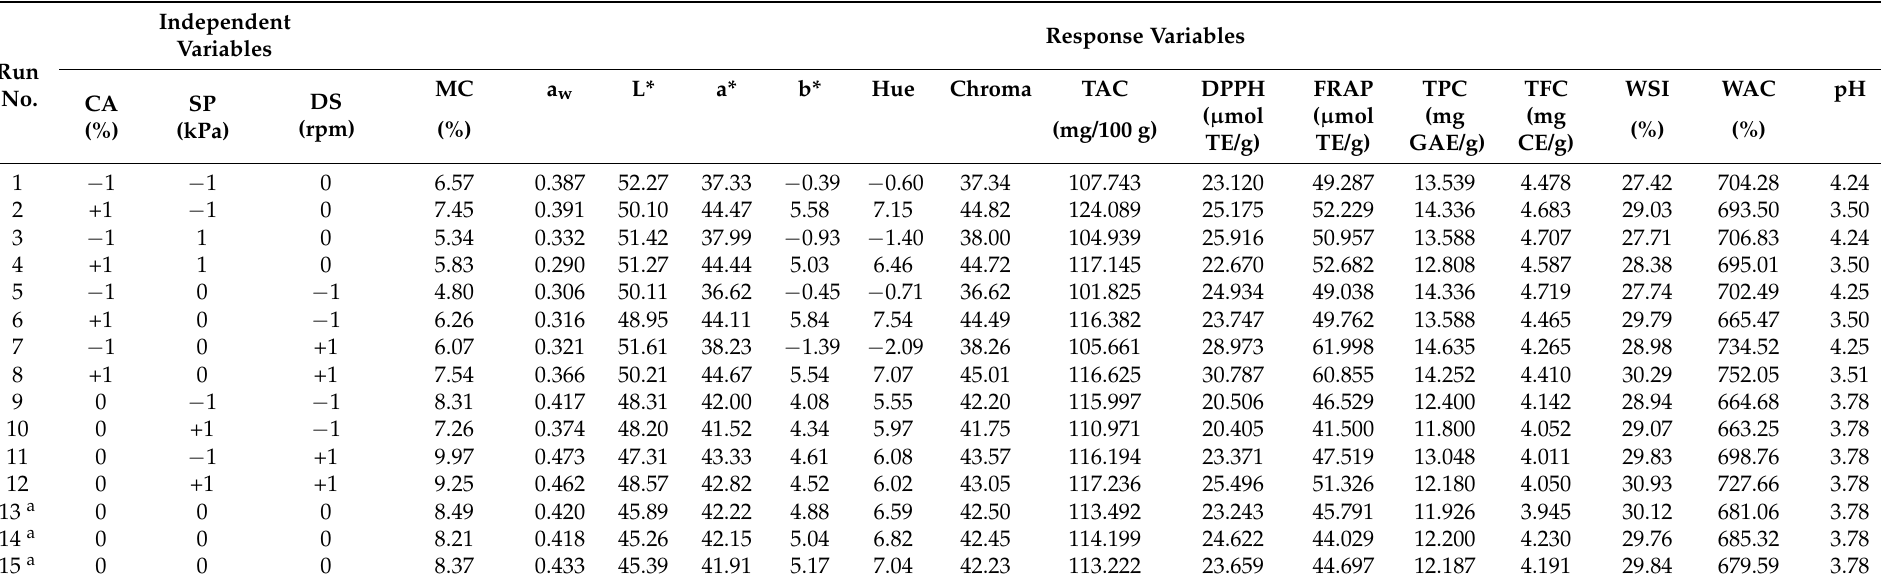
Table 2. Box–Behnken design of RSM and the experimental data obtained using the dependent